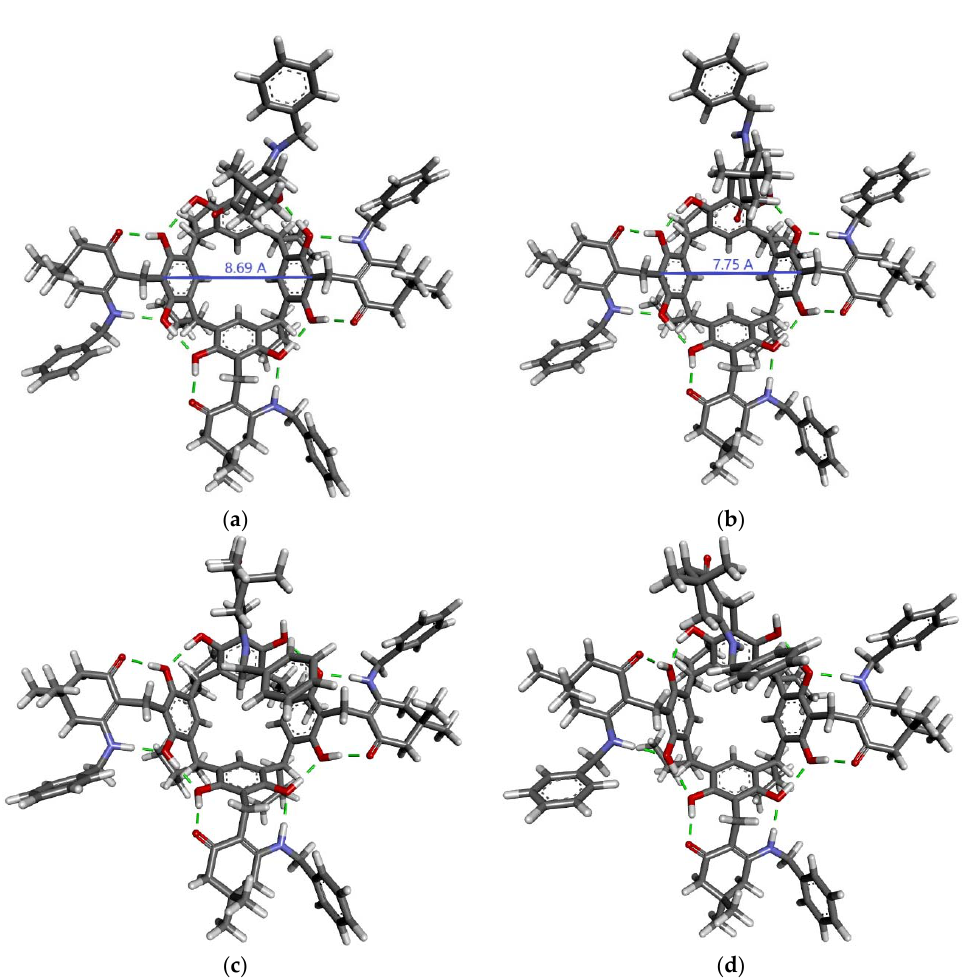
Figure 8 . The transition structures showing changes in the position out ‐ in of the enaminone unit of the all ‐ out conformer. ( a )  E = 70.61 kJ/mol. ( b )  E = 60.78 kJ/mol. ( c )  E = 46.10 kJ/mol. ( d )  E of the all - out conformer. ( a ) ∆ E = 70.61 kJ / mol. ( b ) ∆ E = 60.78 kJ / mol. ( c ) ∆ E = 46.10 kJ / mol. = 61.78 kJ/mol. ( d ) ∆ E = 61.78 kJ /